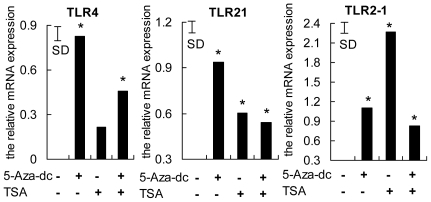
DNA methyltransferase inhibitor 5-Aza-dc and/or the histone deacetylase inhibitor TSA increased TLR4, TLR21 and TLR2-1 expression.Peripheral blood mononuclear cells were inoculated with S. enteritidis without additions (controls) or in the presence of 5-Aza-dc, TSA or TSA plus 5-Aza-dc. Relative abundances of TLR4, TLR21 and TLR2-1 mRNA were analyzed by qPCR and normalized to β-actin mRNA. Data are means (n = 3) and comparisons were made to expression in the controls (-,-). The vertical bar is the SD from the error mean square of the ANOVA, * indicates P<0.05.